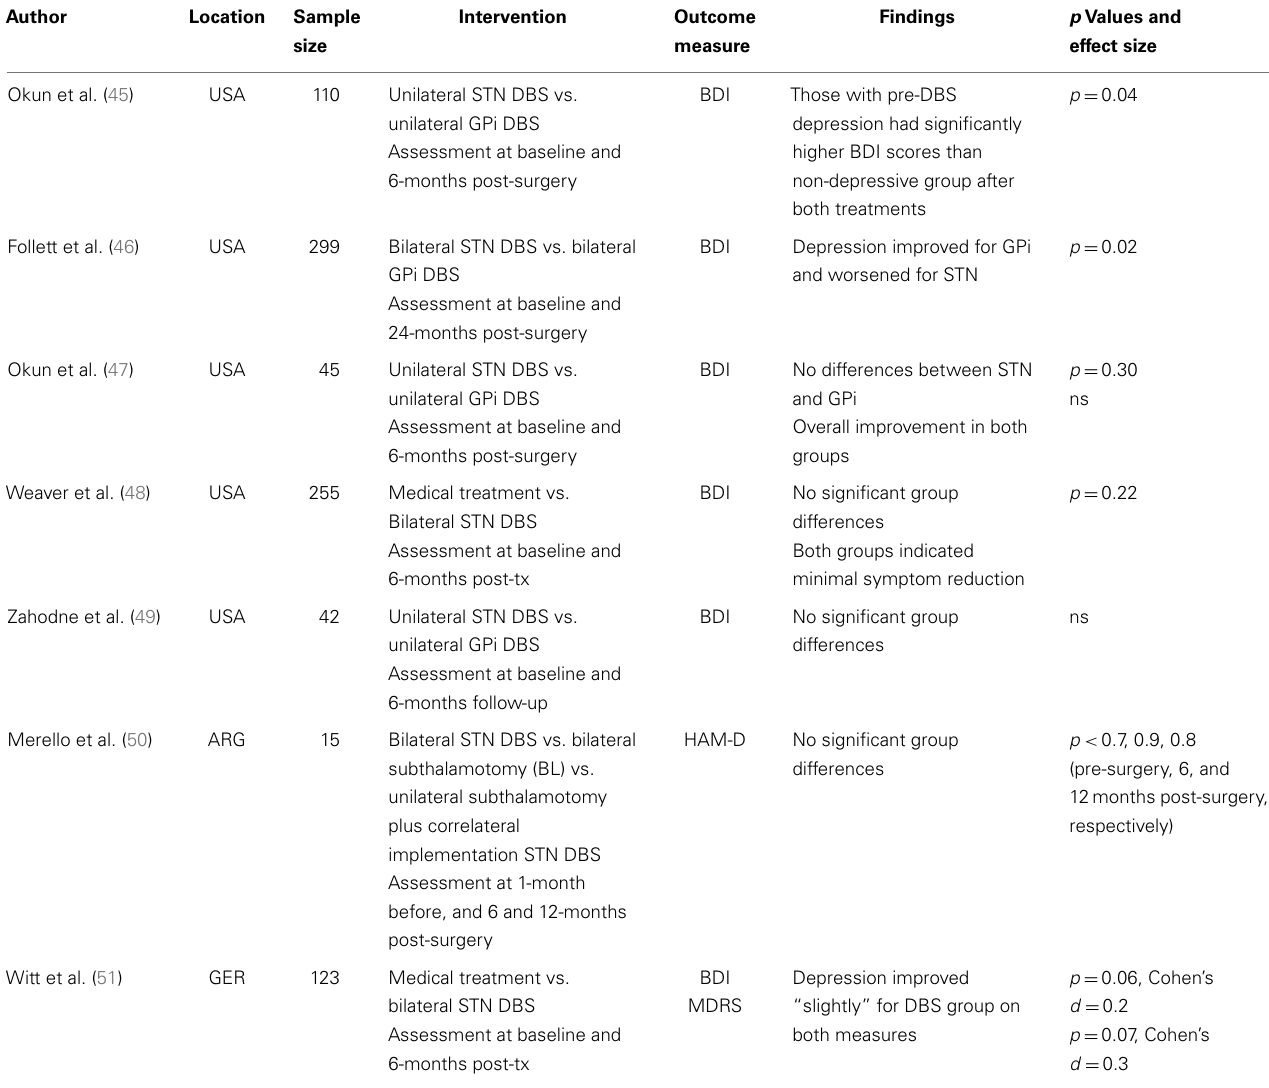
Table 1 | Randomized clinical trials included in the present review